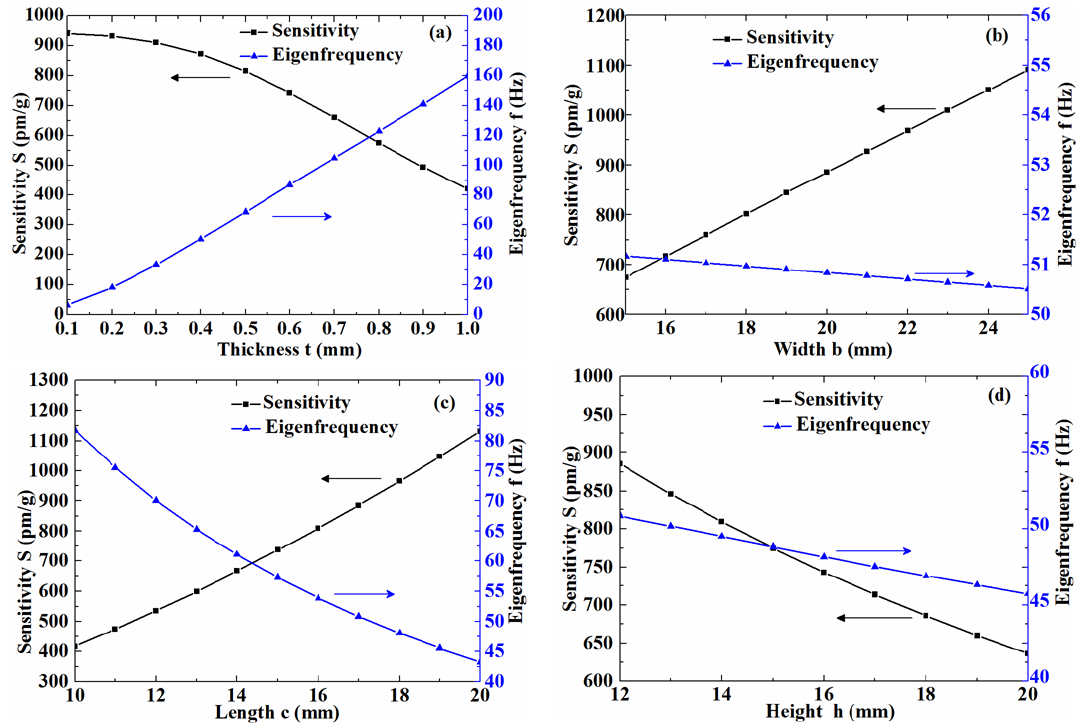
Figure 3. The influence of major parameters on the sensitivity and eigenfrequency. The influence of thickness t ( a ); the influence of width b ( b ); the influence of length c ( c ); the influence of height h ( d ).